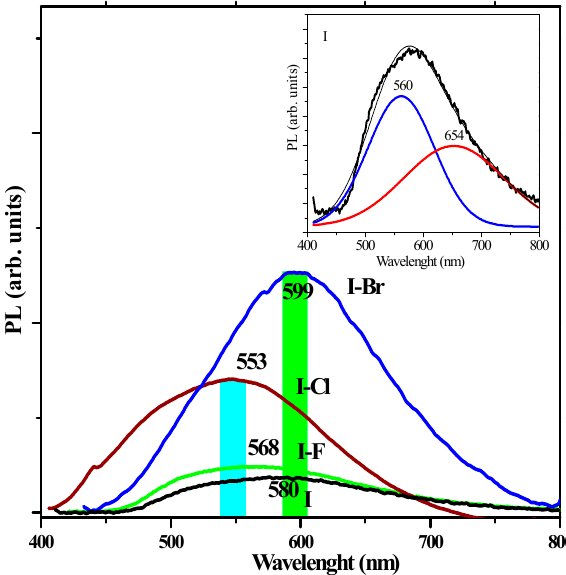
Figure 10. Photoluminescence spectra at room temperature of I , I − F , I − Cl , and I − Br crystals. In the inset, the PL deconvolution of I crystal can be seen.